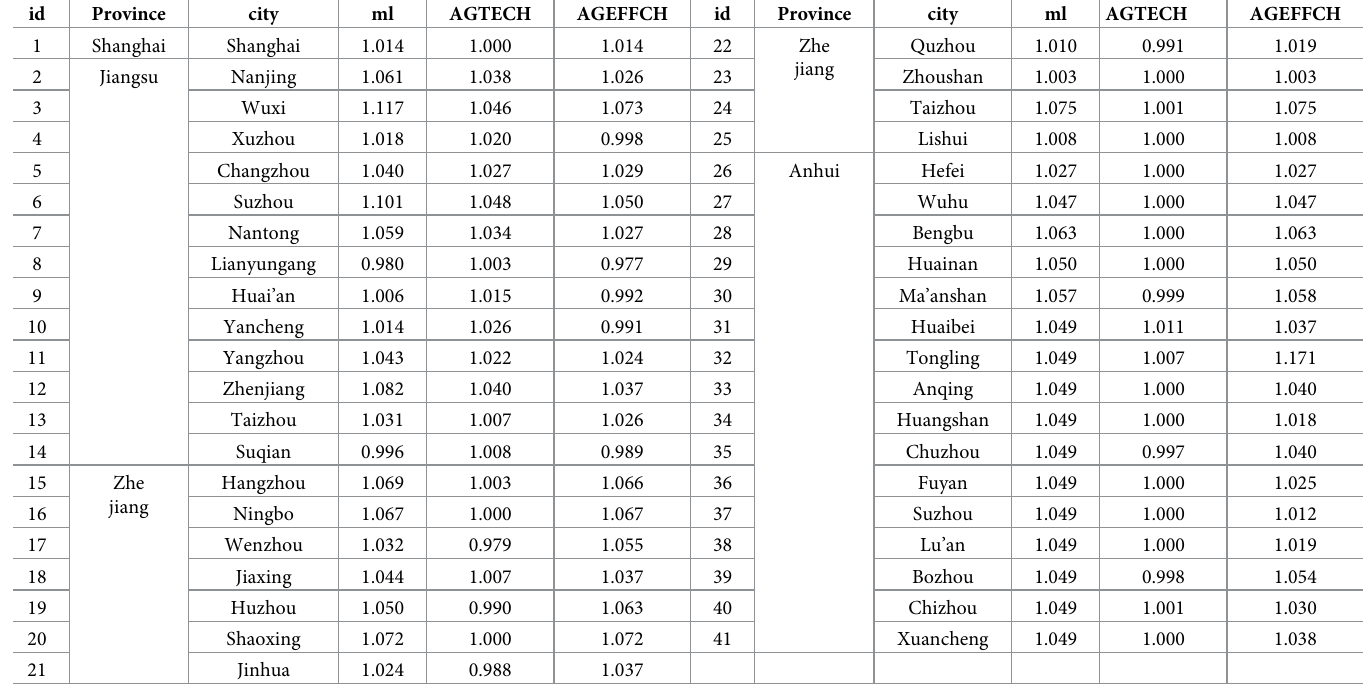
Table 3. Average value of AGTFP and its decomposition in the YRD region from 2001 to